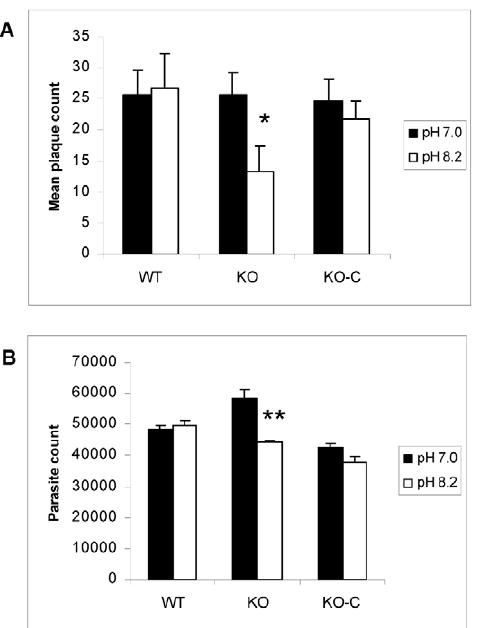
Figure 7. Parasites lacking TgGCN5-A are defective in recov- ering from alkaline stress. Equal numbers of extracellular wild-type (WT), D GCN5-A (KO), or complemented D GCN5-A (KO-C) parasites were subjected to alkaline (pH 8.2) or control (pH 7) media for 30 min at 37 u C in 5% CO 2 . Following treatment, the parasites were allowed to infect HFF monolayers and incubated under normal culture conditions. A. Parasite growth was monitored with a standard plaque assay at day 5 (* denotes p=0.017). B. Viability assay was set up as described above, but growth was monitored with the PCR-based B1 assay (** denotes